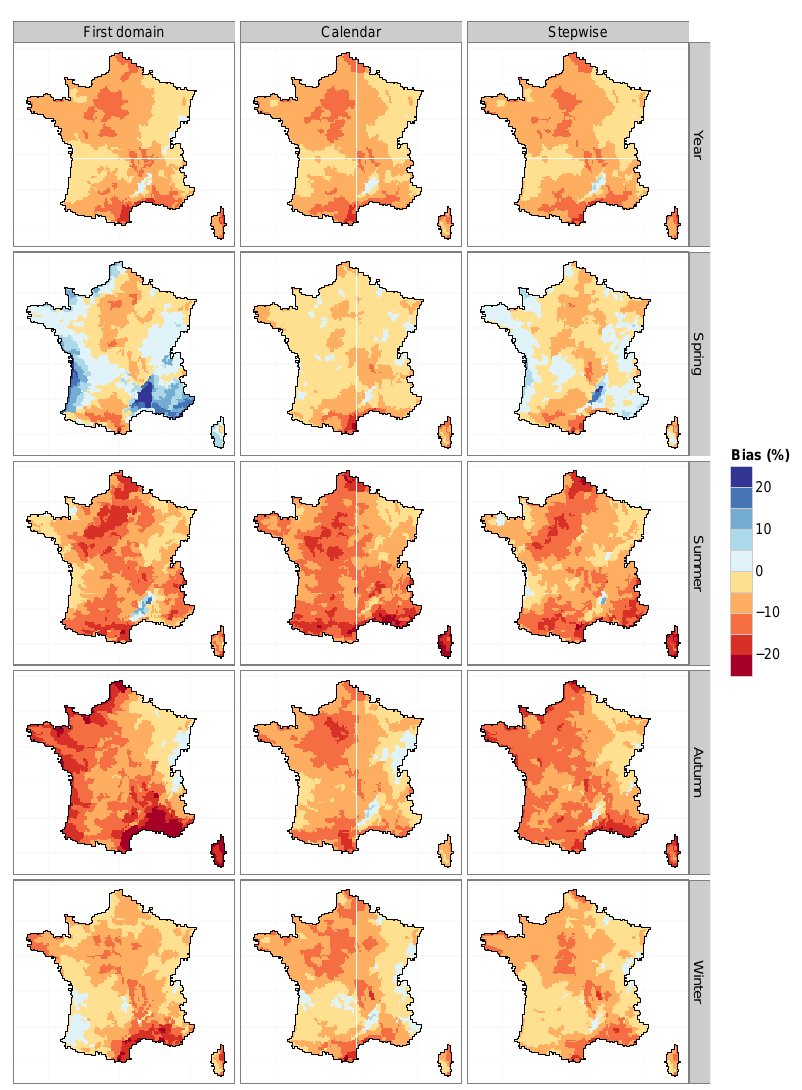
Figure 7. As for Fig. 6, but for precipitation. Red corresponds to an underestimation for precipitation. Minimum bias of − 34% for the first domain selection in autumn and maximum bias of 41% for the first domain selection in